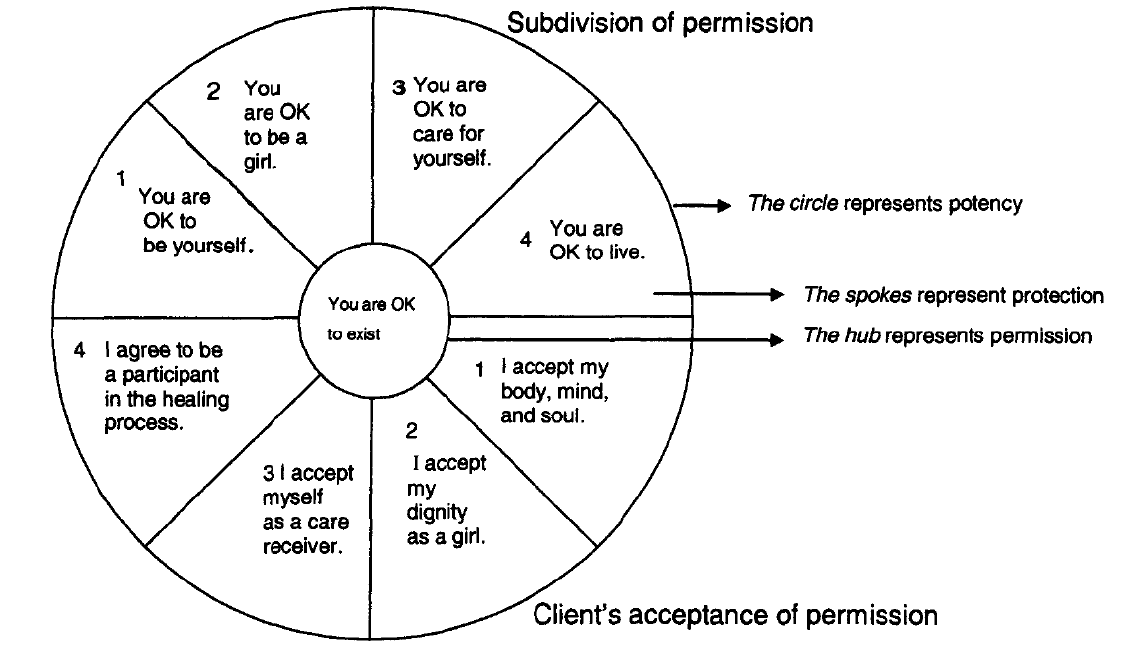
Figure 22: The 3 Ps Wheel (Priya, 2007,